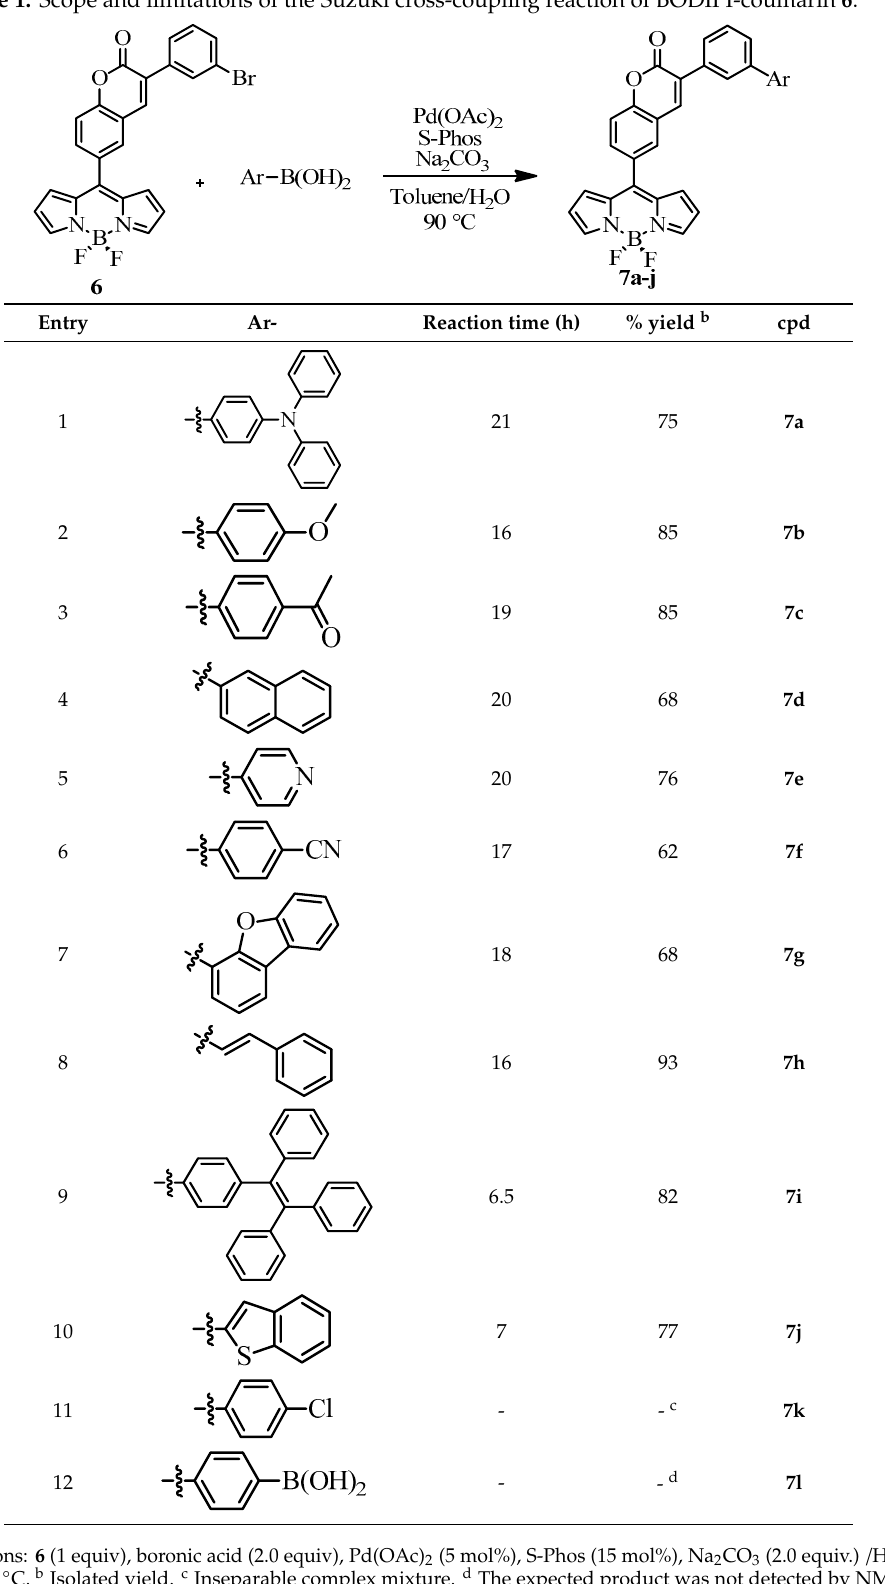
Table 1. Scope and limitations of the Suzuki cross-coupling reaction of BODIPI-coumarin 6 . a.